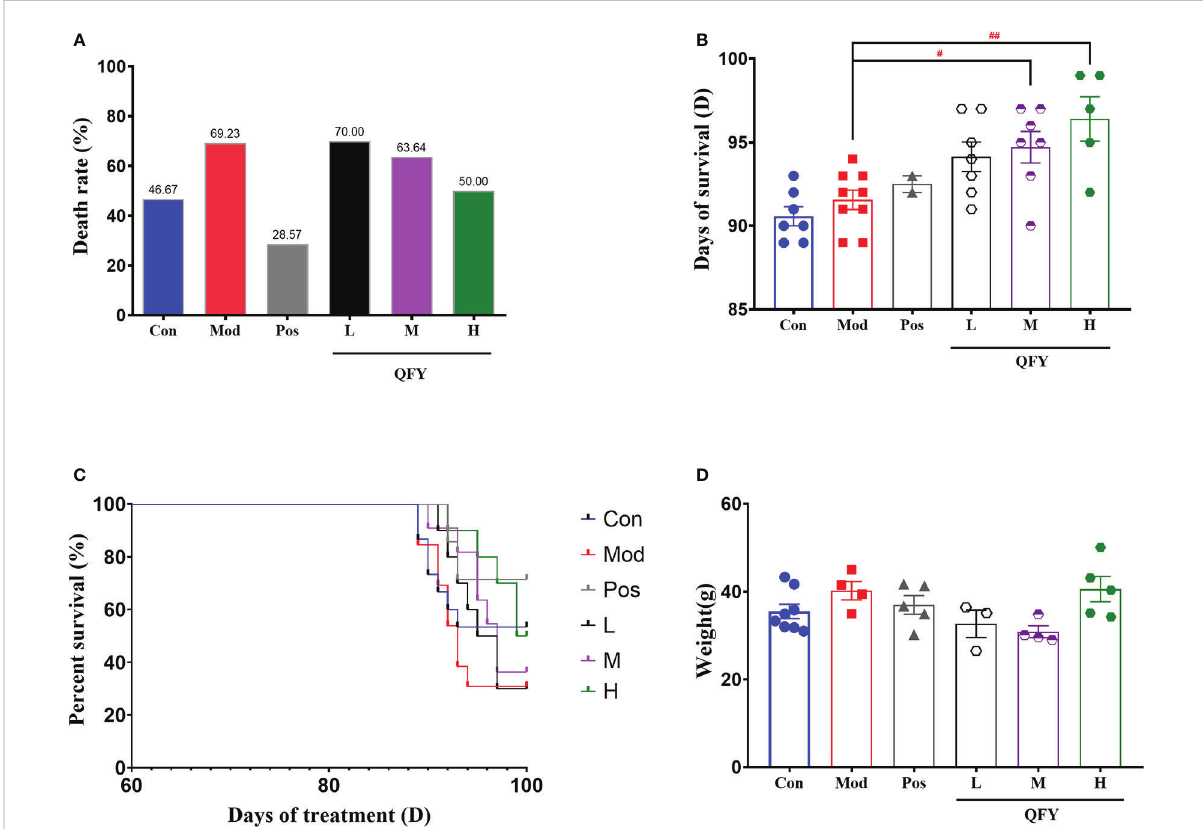
FIGURE 2 Effects of Qi-Fu-Yin on environmental cold stress-induced mortality in aged APP/PS1 transgenic mice. (A) The percent of death, (B) Days of treatment on death, (C) The percent of survival. (D) Weight after cold stress. Mean ± SEM, n=3~8, vs control (Con) group, unpaired Student`s t -test; # P <0.05, ## P <0.01, vs model (Mod) group, one-way ANOVA analysis followed by Dunnett ’ s multiple comparisons test, Graphad Prism 8.0.1